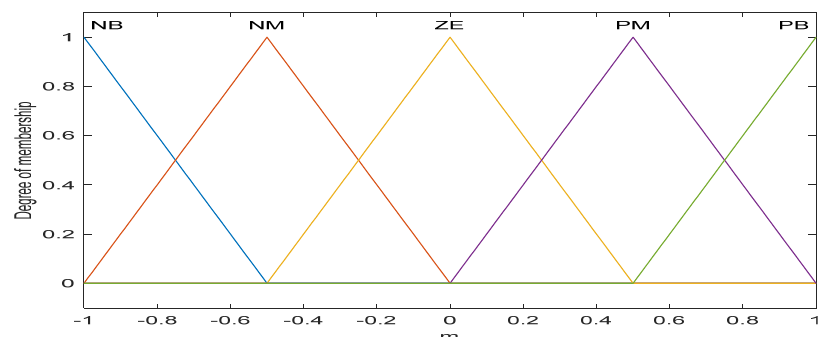
Figure 11. MFs for adaptation gain (m).